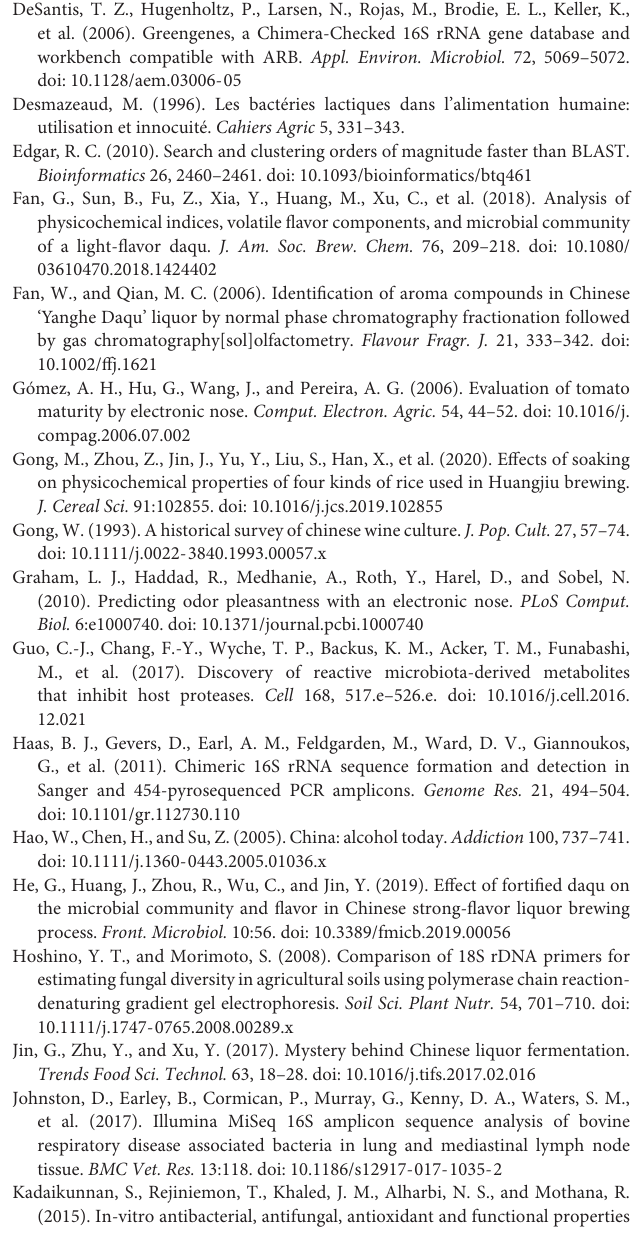
Supplementary Figure 1 | Rank-abundance curve. Supplementary Figure 2 | Comparative analysis of bacterial phenotypic